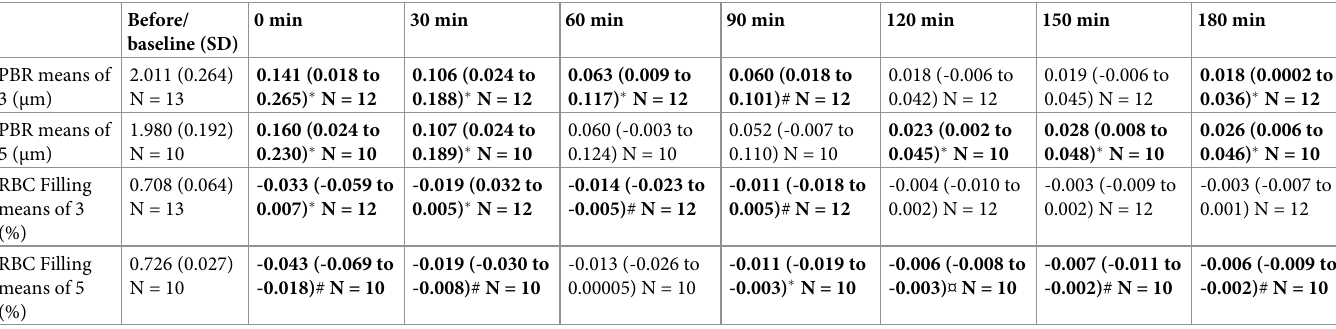
Table 6. Results of a drinking a cup of coffee before and at times 0–180